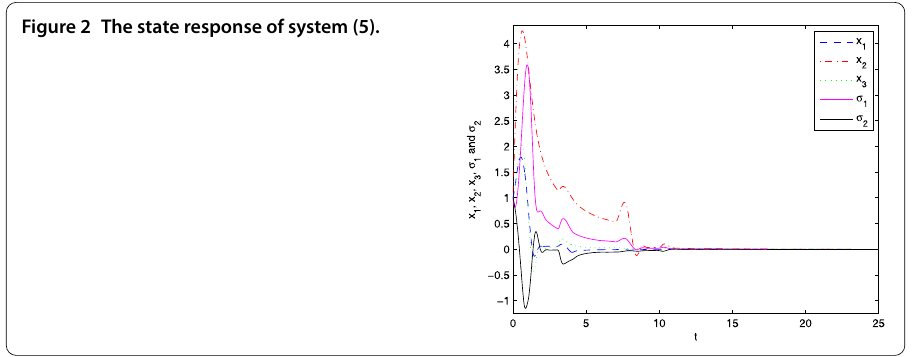
Figure 2 The state response of system